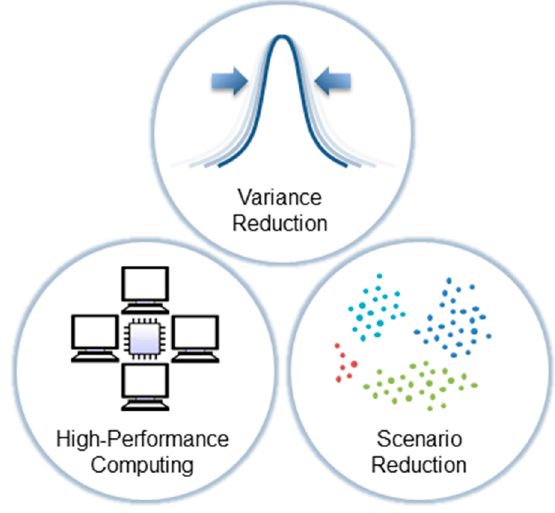
Figure 3. Types of techniques within CEE.